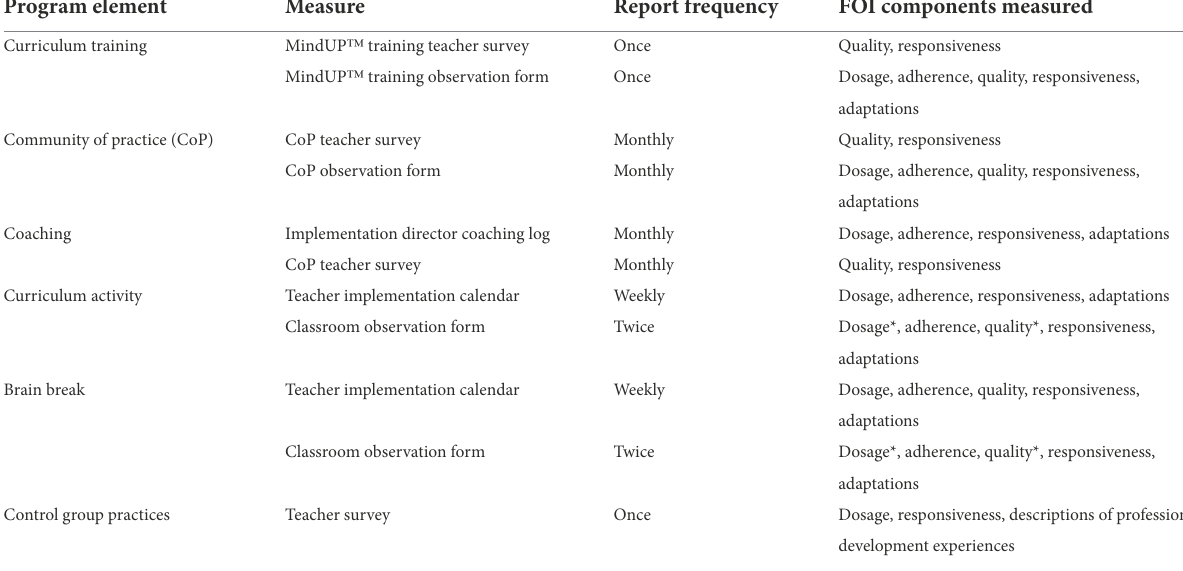
TABLE 3 Fidelity of implementation measures of program elements by frequency and components measured.